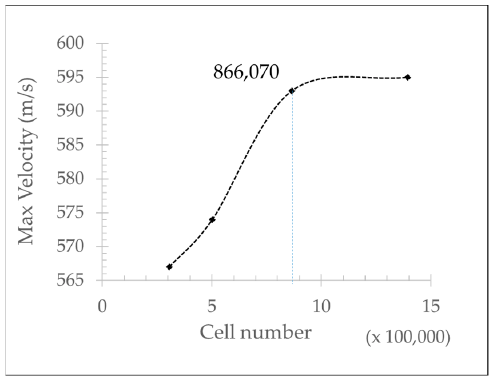
Figure 6. Grid dependency for maximum velocity of the flow. Mesh